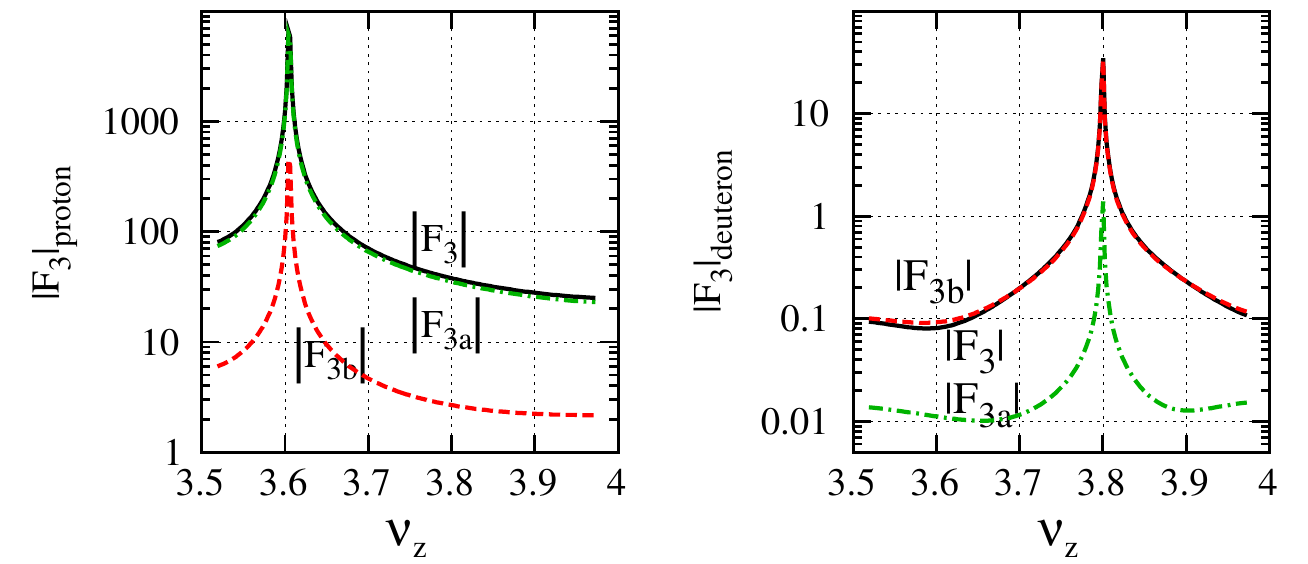
FIG. 2. Graph of j F 3 j at the location of the rf dipole as a function of the vertical betatron tune (cid:5) p ¼ 2 : 1 GeV =c and polarized deuterons (right) at p ¼ 1 : 85 GeV =c . The curves for F 3 from the terms in ð (cid:5) 2 0 þ G Þ K